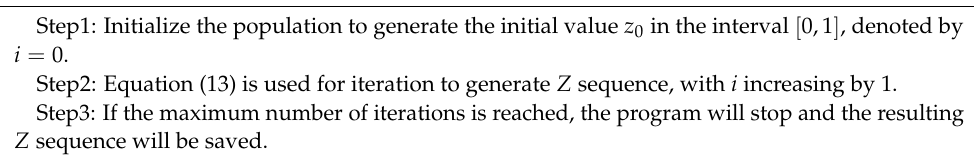
Algorithm 1 Population